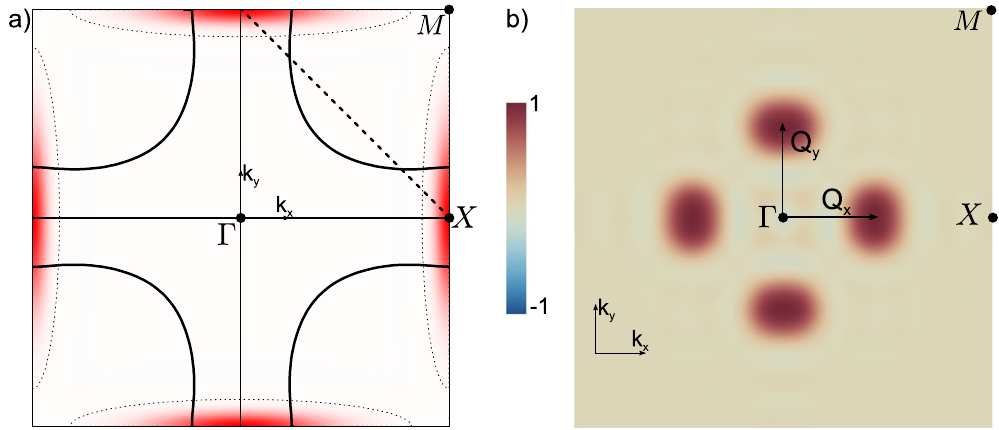
Figure 4. Spectral analysis of ρ Od . Presentation of the spectral analysis of the d -wave component of the charge density on oxygen atoms. In ( a ), we present the magnitude of gap envelop F k in the first Brillouin zone of the square lattice (red area delimited by the dotted line). ( b ) Fourier transform of the charge density of Fig. 3(a) in the first Brillouin Zone. The charge order is organized preferentially along Q x and Q y that are parallel to k x and k y